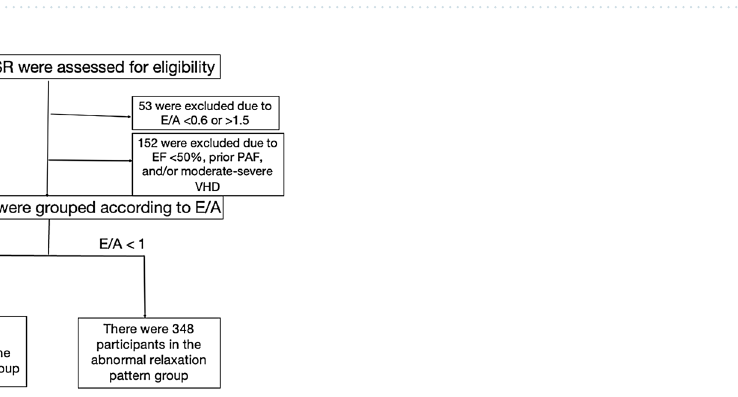
Figure 1. Representative early advanced-age cases with ( A ) normal cardiac size and normal inflow pattern, and, ( B ) abnormal relaxation pattern. Upper panel: Three-camber view. Lower panel: Transmitral inflow by pulse Doppler method.